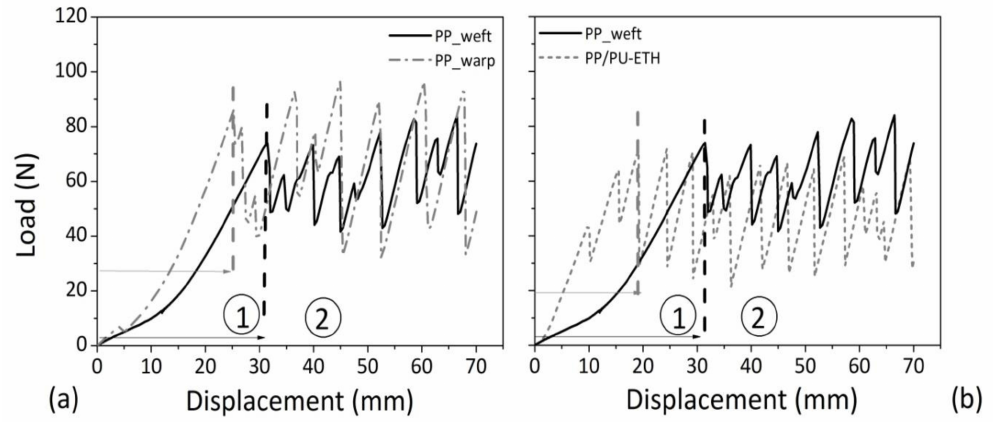
Figure 7. Load-displacement curves of representative samples for each tested material by tear testing: ( a ) the basic PP fabric in warp and weft direction, ( b ) impregnated samples with polyether-based polyurethane in weft